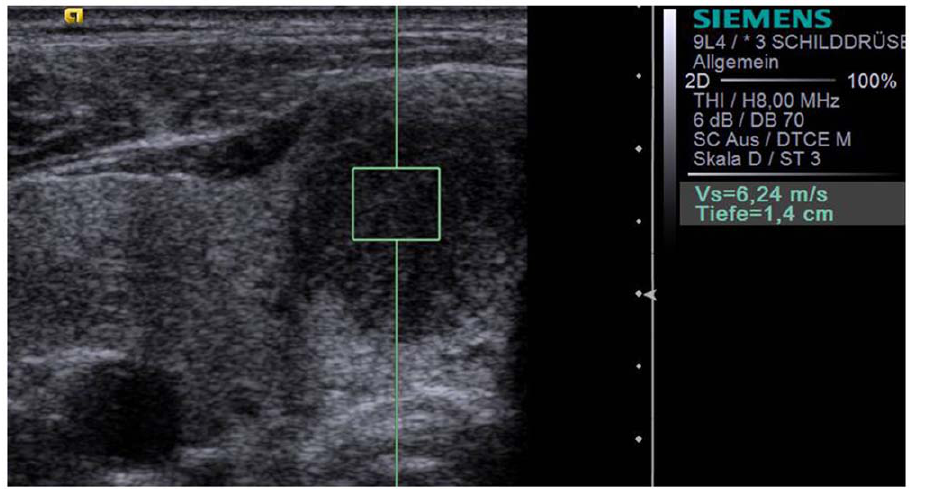
Figure 2. Acoustic Radiation Force Impulse Imaging (S2000, 9L4 probe at 9 MHz) of the same patient a in Figure 1 with the ROI placed within a hypoechoic thyroid nodule in the right thyroid lobe measuring a velocity of 6.24 m/s. Histology revealed papillary carcinoma.